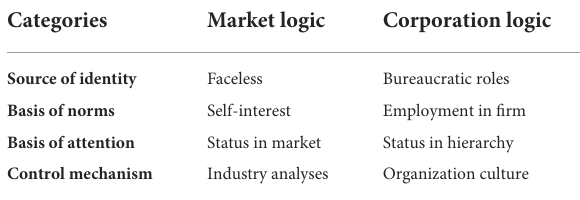
TABLE 1 Ideals of institutional orders (adapted from Thornton et al.,